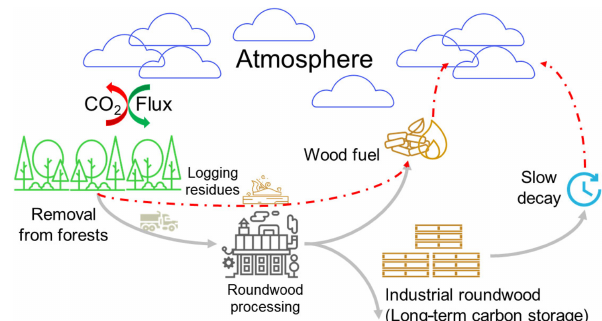
Figure 9. Concept for accounting for carbon emission and storage dynamics from forests and harvested roundwood. Wood fuel is as- sumed to be emitted within the optimization step in which it is har- vested. Industrial roundwood enters a long-term storage pool, from which slow turnover happens and is tracked via the IPCC (2019) methodology described in Eqs.